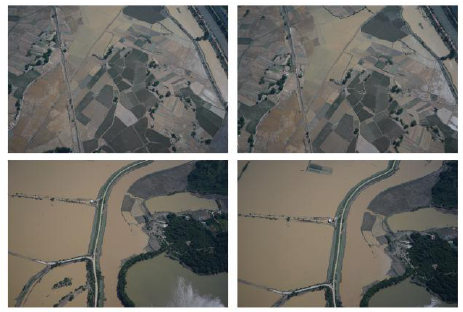
Figure 1.UAV remote sensing data set of Poyang